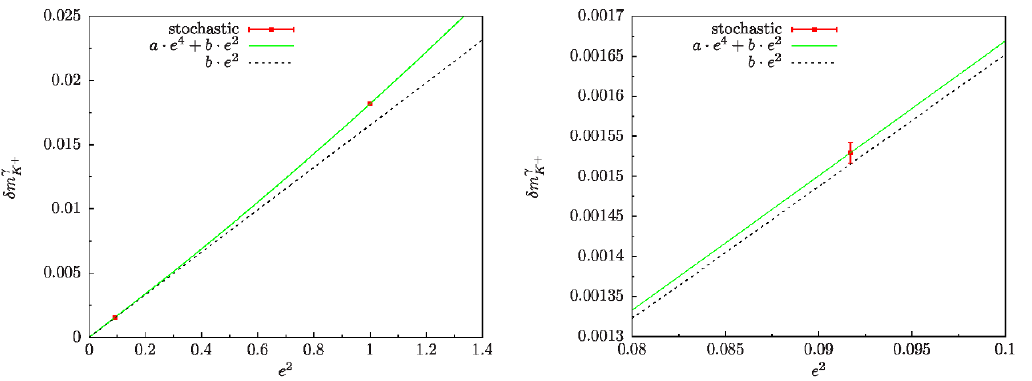
Figure 18 . The QED correction to the mass of a charged kaon from the stochastic data plotted against the electromagnetic coupling e 2